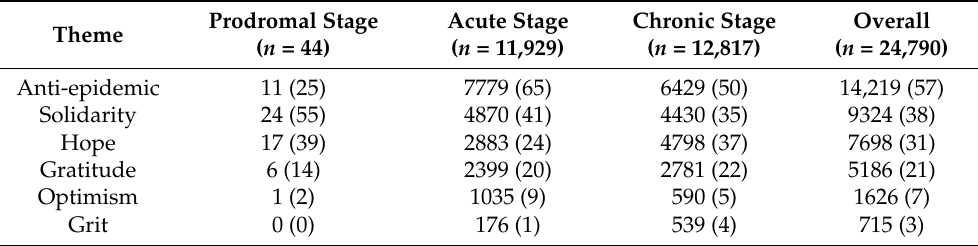
Figure 3. Semantic network depicting the association among different concepts based on co-occurrence.